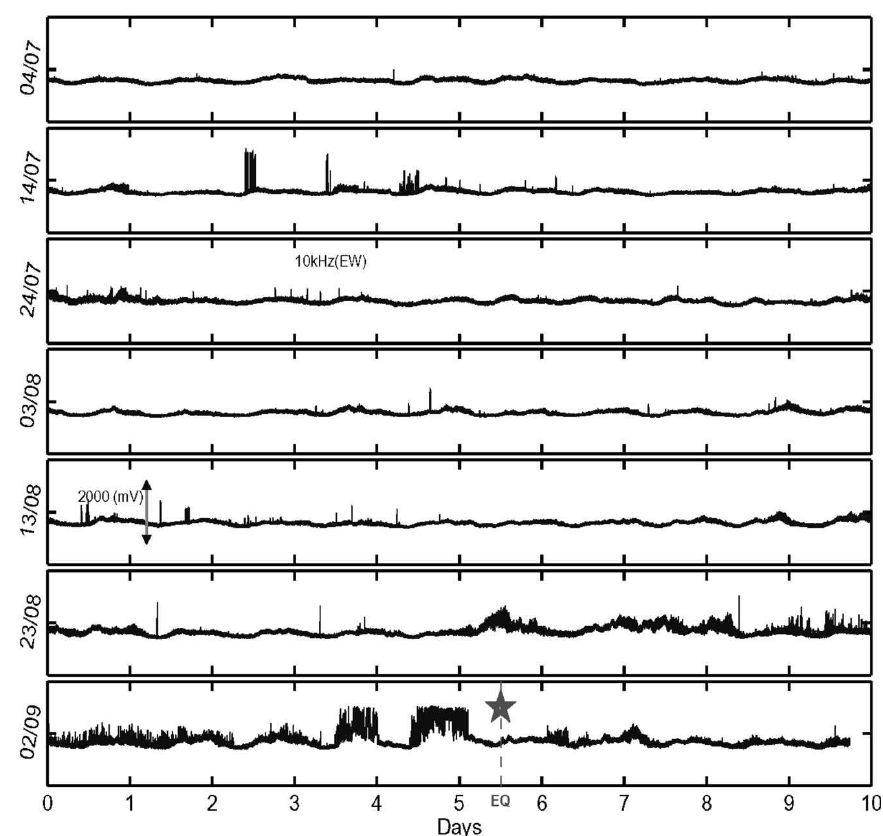
Fig. 1. Time series of the 10kHz (East-West) magnetic field strength between 4 July and 11 September 1999, in arbitrary units. The star indicates the time of the Athens EQ occurrence. A long duration candidate precursory anomaly emerged from a few days up to a few hours before the EQ. It is clear that the candidate precursor is embedded in a long duration quiescence period concerning the detection of EM disturbances at the kHz frequency band.